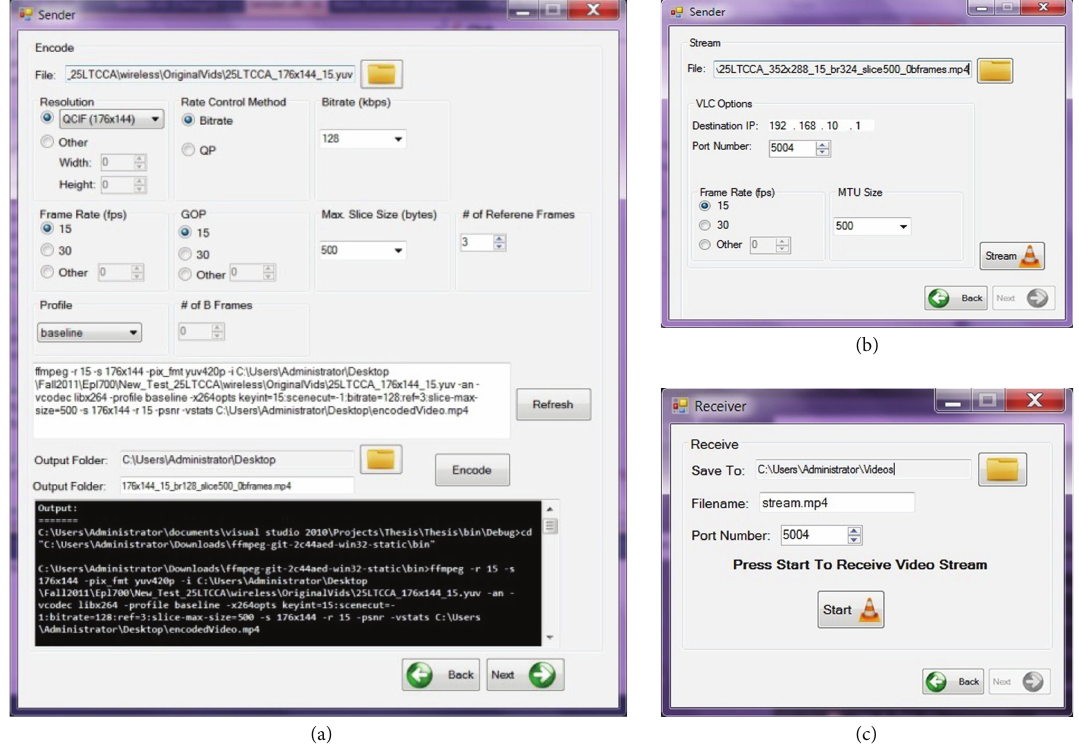
Figure 2: Screenshots depicting the open-source-based medical video communication platform. (a) Encoding interface to the x264 codec. Additional parameters can be inserted via the command line text box situated in the middle of the interface, (b) streaming interface at the sender’s side using the VLC media player, and (c) receiver’s interface at the receiver’s